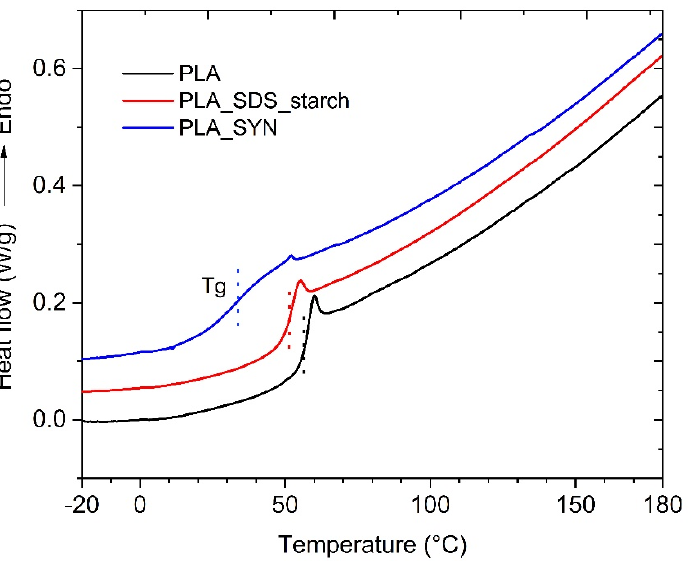
Figure 4. DSC thermograms at 10 °C/min of neat PLA, dried PLA dispersion with SDS and starch as surfactant and stabilizer, respectively, (entry 3, Table 1) and dried PLA dispersion with SYN (entry 23, Table 3). Second heating step. Thermograms were arbitrarily vertically shifted for clarity.